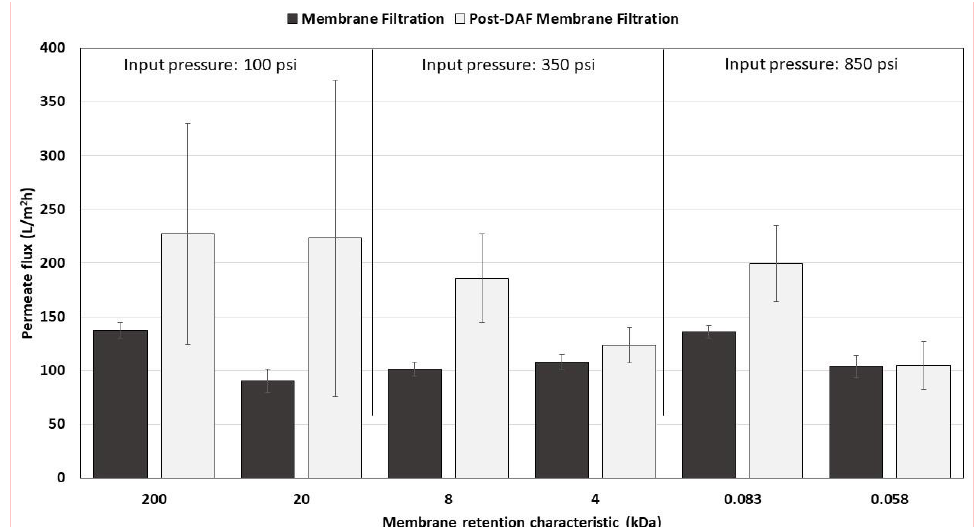
Figure 7. Permeate fluxes (L/(m 2 h)) of different membranes in both experiments—membrane filtration and post-DAF membrane filtration.